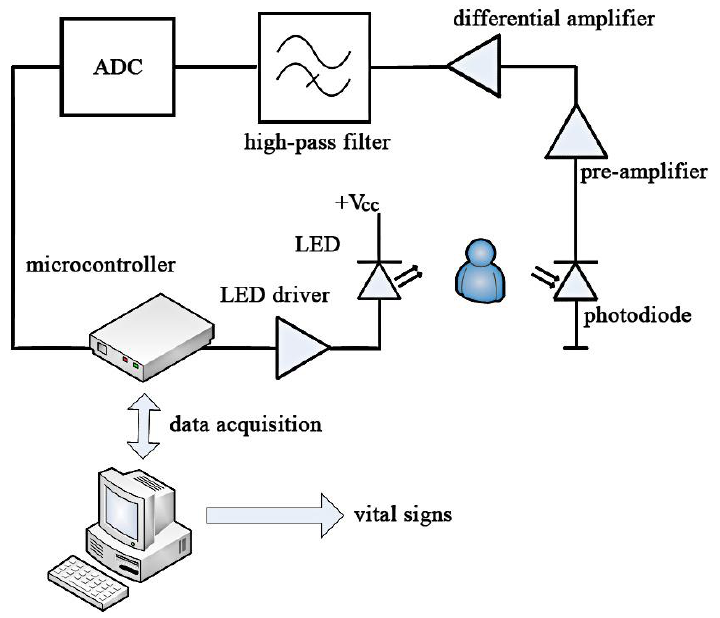
Figure 3. Block diagram of the mOEPS circuit.